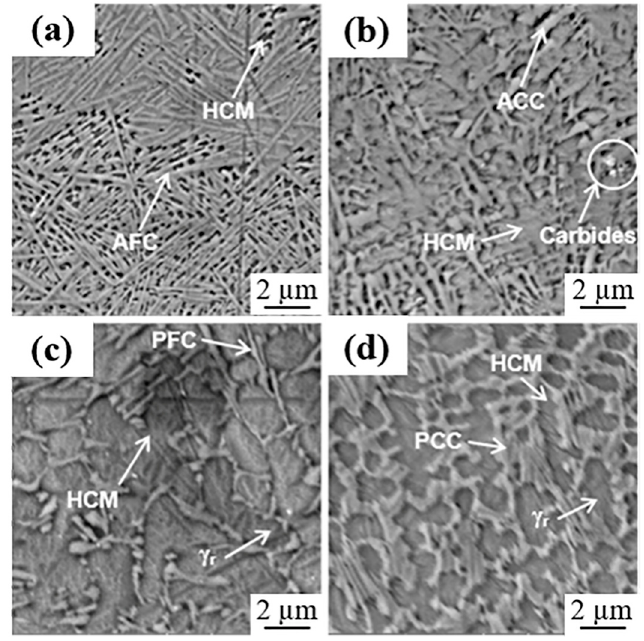
Figure 8. Microstructure of the melting zone (H1) to 150 W (P1), ( a ) Sample 1, ( b ) Sample 2, ( c ) Sample 3 and ( d ) Sample